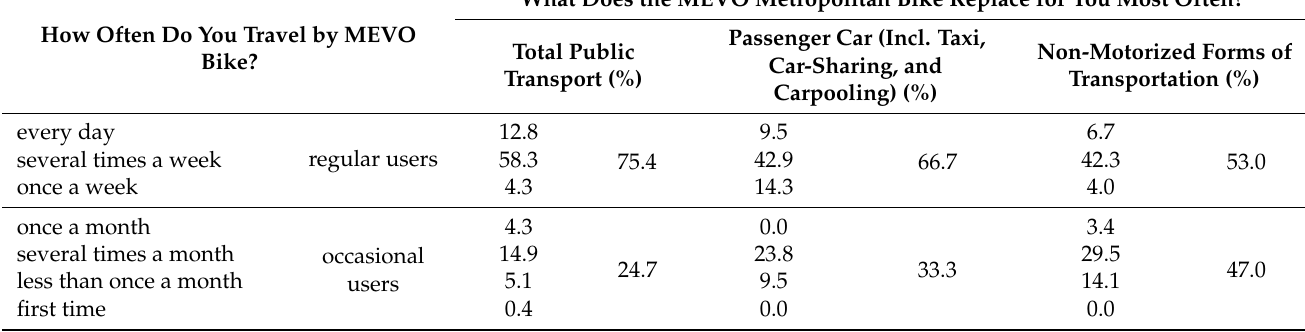
Table 5. What does the metropolitan bike replace for you most often? This regards the frequency of travel by municipal bikes.